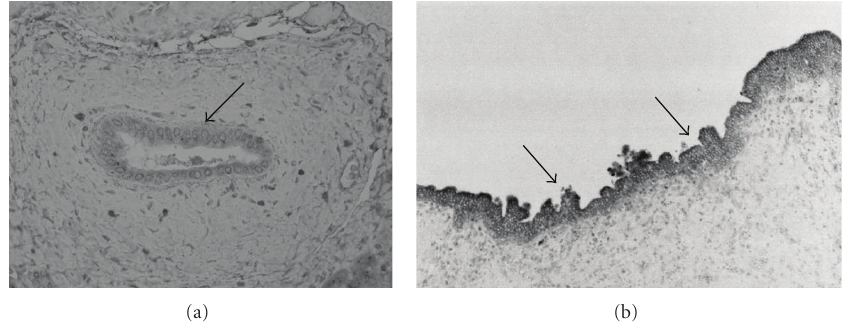
Figure 2: Immunohistochemical staining for human beta defensin (hBD)-1 (a) and hBD-2 (b). (a) Normal liver. Septal bile ducts are positive for hBD-1. (b) Extrahepatic biliary obstruction. Biliary epithelium of the intrahepatic large bile duct showing cholangitis strongly expresses